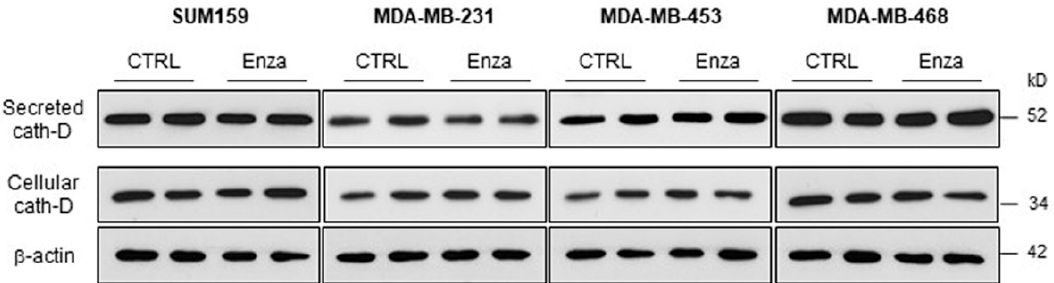
Figure 4. E ff ect of the AR inhibitor enzalutamide on Cath-D expression and secretion in TNBC cells. AR-positive TNBC cells were incubated with DMSO (control) or with enzalutamide (20 µ M) in the absence of fetal calf serum (FCS) for 24 h. Whole cell extracts (30 µ g proteins) and conditioned media (40 µ L) were separated by 13.5% SDS-PAGE. Cellular Cath-D and secreted Cath-D were detected with the appropriate anti-Cath-D antibodies. β -actin, loading control. kD, molecular mass in kiloDaltons.